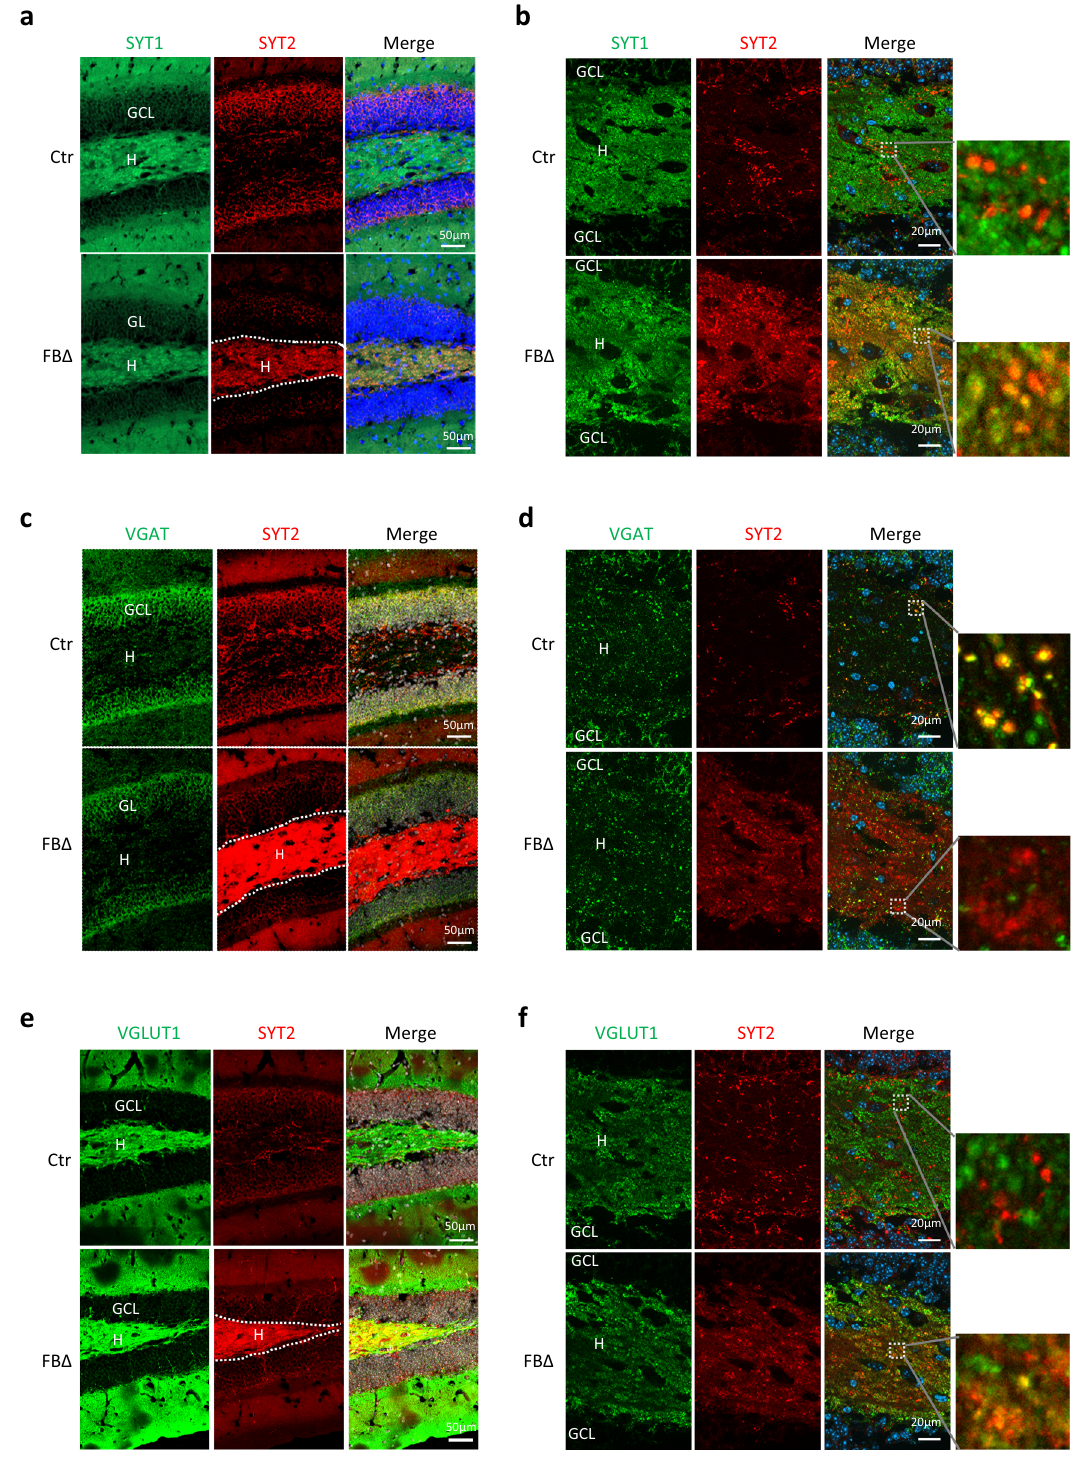
Fig. 9 ATR deletion changes location and enrichment of SYT2. a Sagittal sections from 3-month-old control (Ctr) and ATR-FB Δ (FB Δ ) mice were stained with DAPI (blue), SYT1 (green) and SYT2 (red). The dentate gyrus area is shown. GL Granular Layer, H Hilus. b Immuno fl uorescence analysis of expression patterns of SYT1 and SYT2. Note a high SYT2 expression in granule cells in the GCL in controls, but more abundant and co-localization with SYT1 in mutant hilus (zoom-in pictures on right). c Sagittal sections from 3-month-old control and ATR-FB Δ mice were stained with DAPI (white), SYT2 (red) and VGAT (green). CA: Cornu Ammonis, DG: Dentate Gyrus). d Immuno fl uorescence analysis of expression pattern of VGAT and SYT2. Note a colocalization of VGAT and SYT2 in granule cells in the GCL in controls, but more abundant, yet not overlapping with VGAT, in mutant hilus (zoom-in pictures on right). e Sagittal sections from 3-month-old control and ATR-FB Δ mice were stained with DAPI (blue), SYT2 (red) and VGLUT1 (green). CA Cornu Ammonis, DG Dentate Gyrus. f Immuno fl uorescence analysis of expression pattern of VGLUT1 and SYT2. Note a high VGLUT1 in the hilus, where the SYT2 expression is low, in controls. Strong overexpression and co- localization (puncta) of VGLUT1 and SYT2 in the hilus (right zoom-in pictures). The images are representative from 4 to 5 mice per genotype